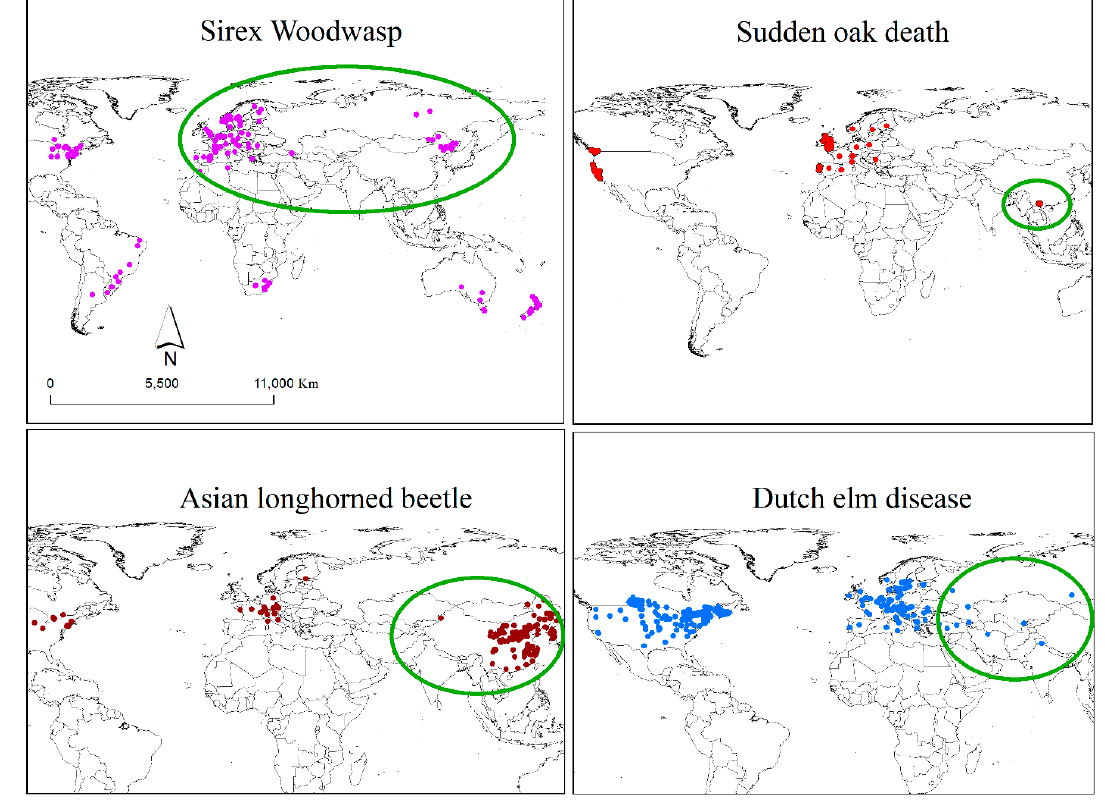
Figure 1. Geographical distribution of Sirex Woodwasp (WW), Asian longhorned beetle (ALB), sudden oak death (SOD), and Dutch elm disease (DED). Native ranges for each invasive are shown in green. Since the origin of DED is not known we assume them to be native to Asia for the purpose of comparison.